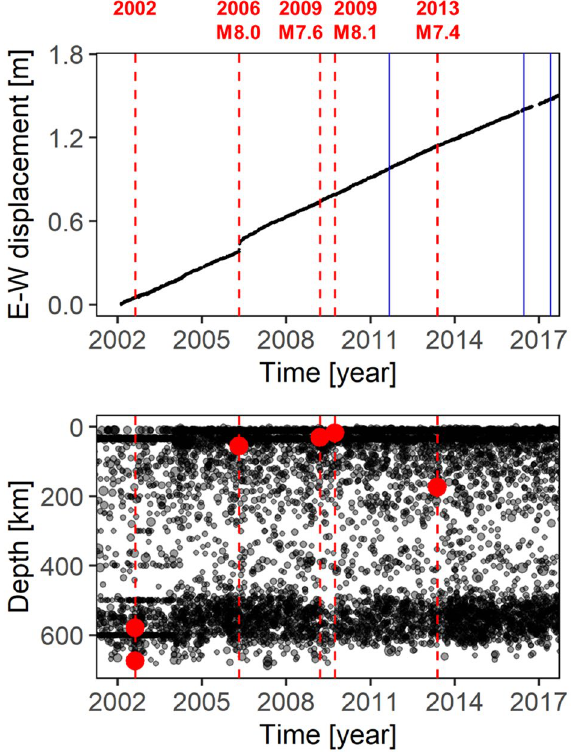
Figure 2. (Top) Example of the GNSS time series data (East–West component at TONG station). (Bottom) Depth-time evolution of the seismicity. The red vertical broken lines and the red circles indicate the occurrences and the focal depths of the respective large earthquakes in Fig. 1. The vertical blue lines indicate the time of the equipment changes for the GNSS station. Figures generated with R 3.x (https ://www.r-proje